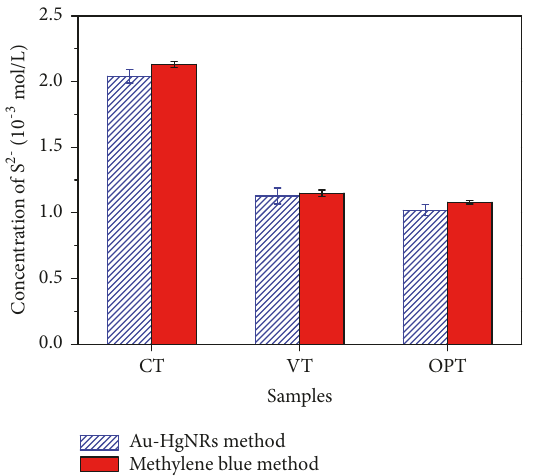
Figure 9: Determination of concentrations of S 2− in real samples (CT:wastewaterfromchrometanningprocess;VT:wastewaterfrom vegetabletanningprocess;OPT:wastewaterfromorganicphosphine tanning